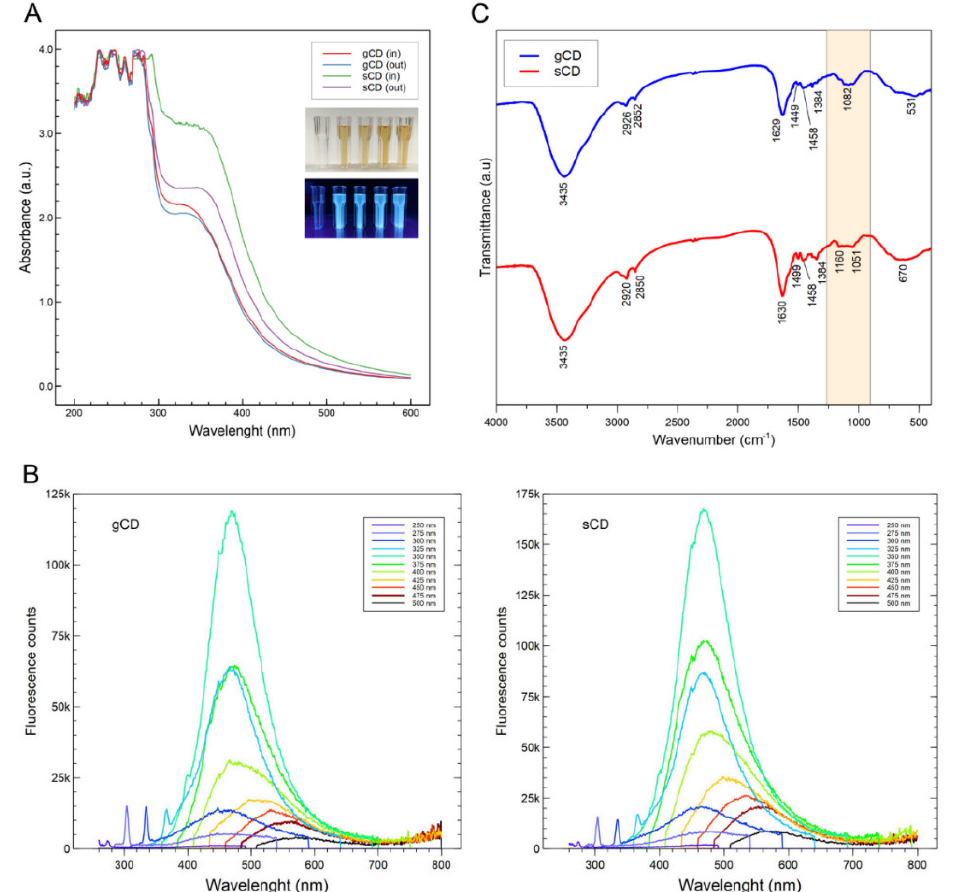
Figure 1. ( A ) Absorption spectra of the glucose (gCD) and saccharose (sCD) carbon dots obtained in this work. Aspect of the water dilutions of the nanoparticles when illuminated with white (upper inset) and ultraviolet light (lower inset); from left to right: solution of glucose and bPEI in water; gCD(in): gCD retained in the 1 KDa MWCO dialysis membrane; gCD(out): gCD eluate from the dialysis membrane; sCD(in): sCD retained and sCD(out): sCD eluate. ( B ) Wavelength-dependent emission spectra of the gCD and sCD carbon dots retained in the dialysis membranes. Wavelength scanning was performed from 250 to 475 nm with steps of 25 nm. ( C ) FT-IR spectra of the carbon dots retained in the dialysis membranes.